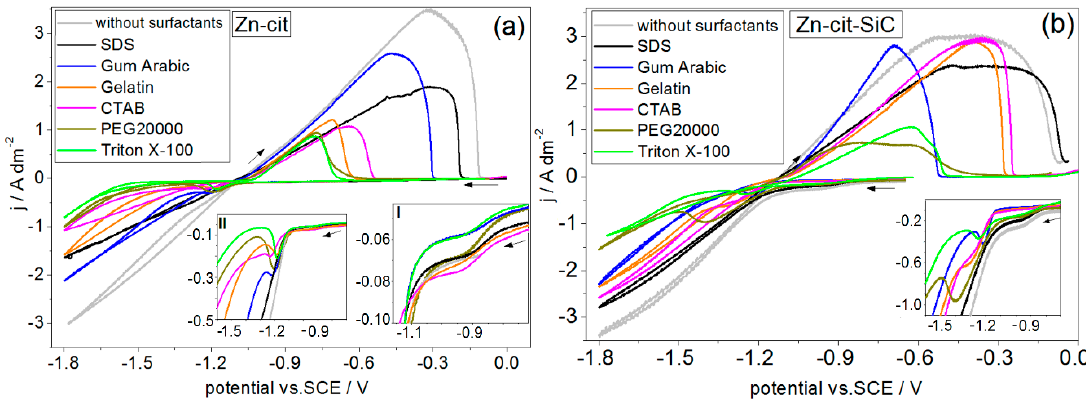
Figure 3. Cyclic voltammograms measured on a Cu substrate in Zn–cit ( a ) and Zn–cit–SiC ( b ) electrolytes with various surfactants added to the bath. ω = 30 rad · s − 1 , scan rate = 20 mV · s − 1 , T = 20 °C. Arrows indicate scan direction.